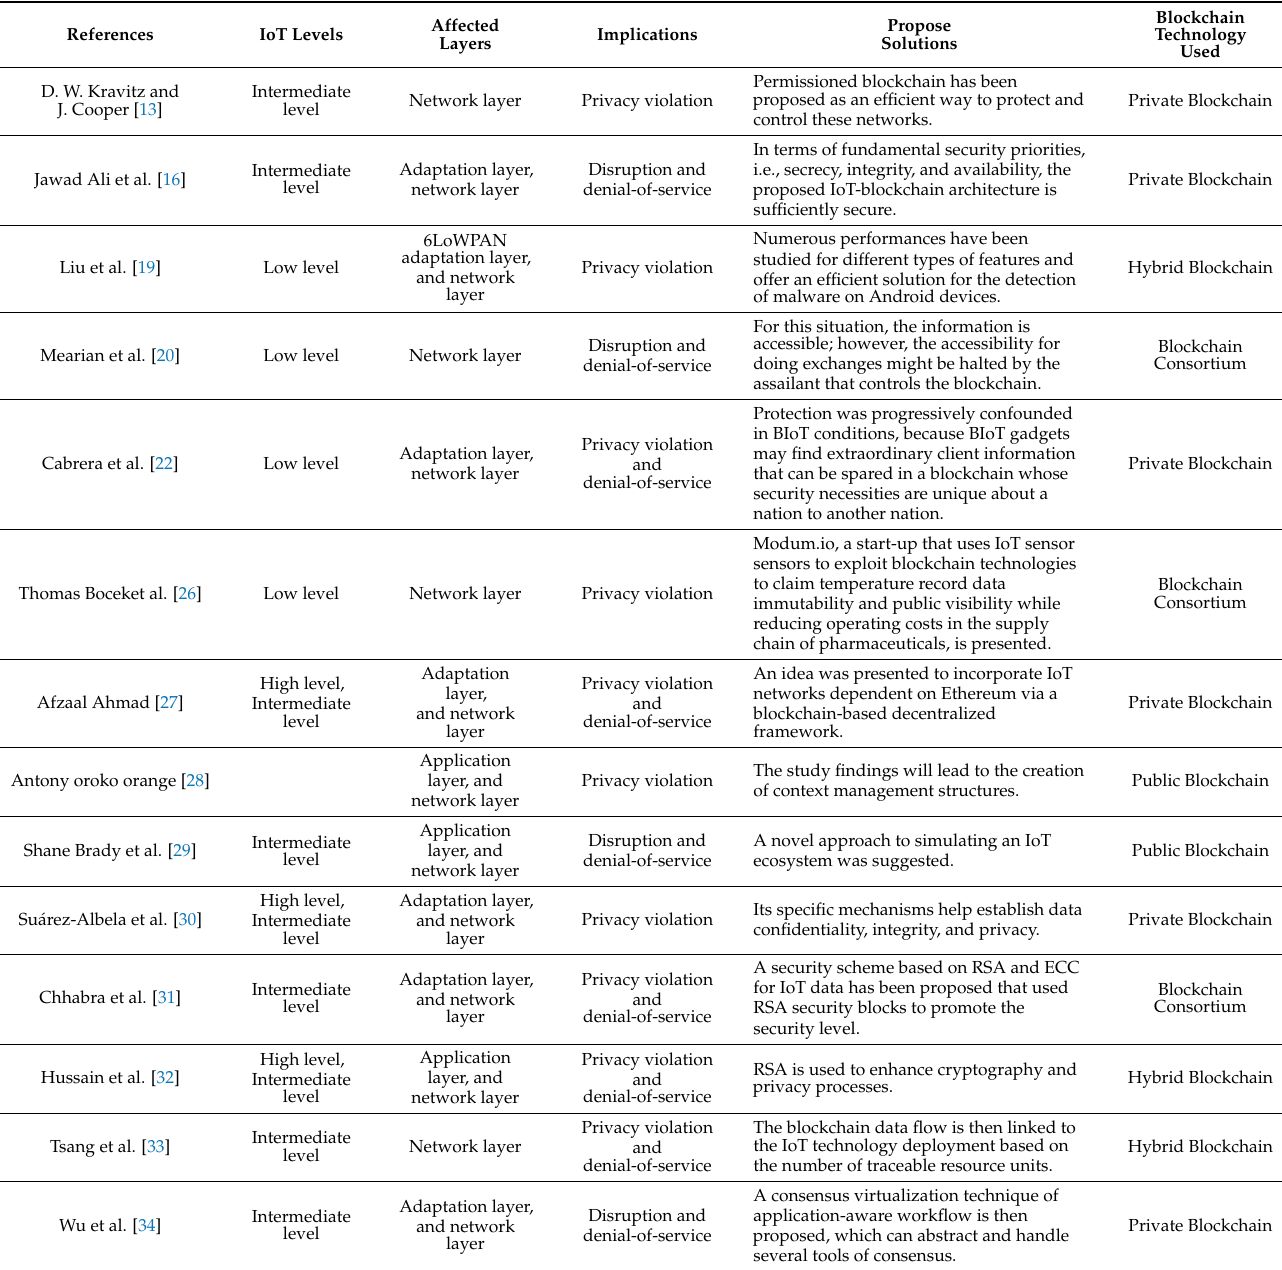
Table 1. Comparative analysis of BIoT